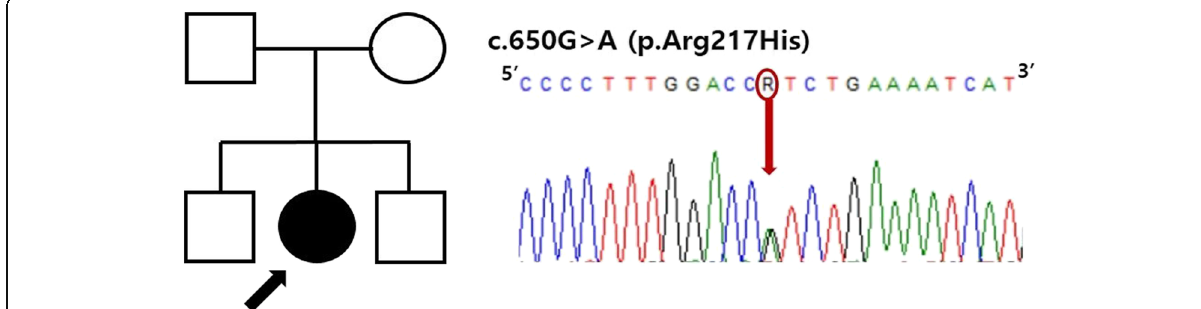
Fig. 2 Sanger-sequencing chromatogram of our patient. Partial sequencing of the cloning allele of SLC25A24 showed the presence of a heterozygous missense mutation, NM_013386:c.650G > A, p.[Arg217His], in exon